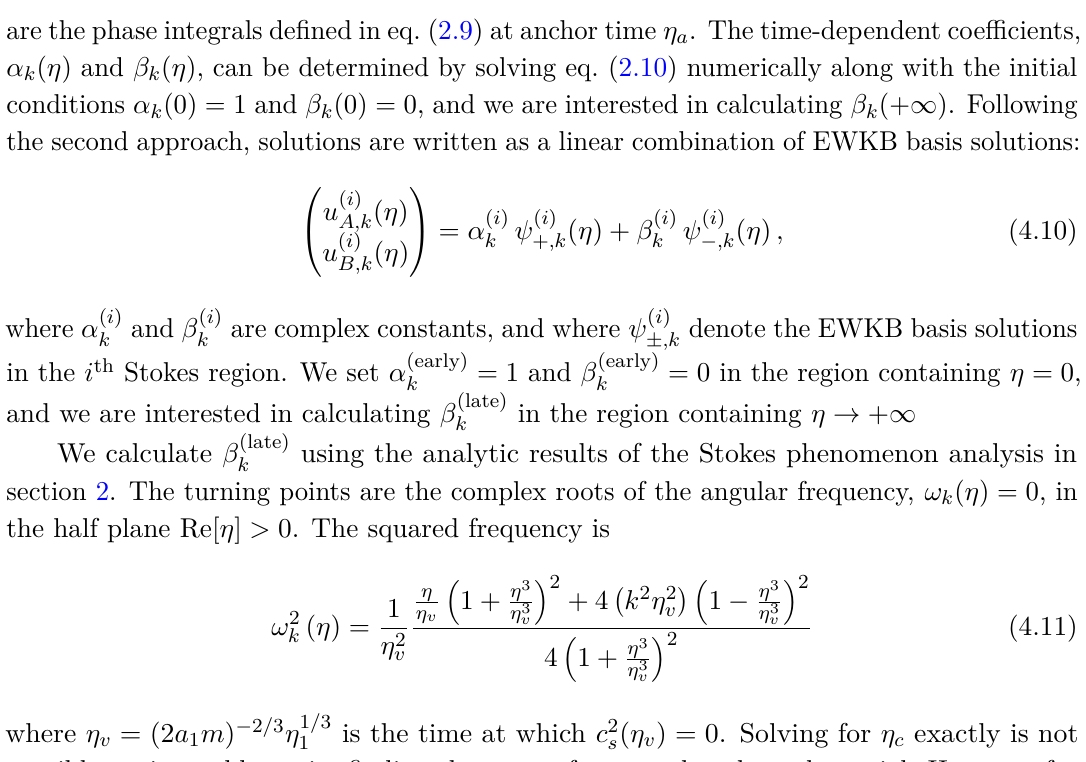
Figure 6 . The left and right figure respectively show the squared sound speed c 2 adiabaticity | µ k ( η ) | η as functions of conformal time η . The sound speed asymptotes to 1 at both early time and late time; at η = η v , the sound speed drops to 0 , as indicated by the red dot. Vanishing sound speed is the condition for catastrophic production of particles to happen. The right figure shows that the non-adiabaticity | µ k ( η ) | η is most enhanced around η v , reaching a maximum value of 3 kη v / 2 ’ 0 . 945( k/a 1 m )( a 1 mη 1 ) 1 / 3